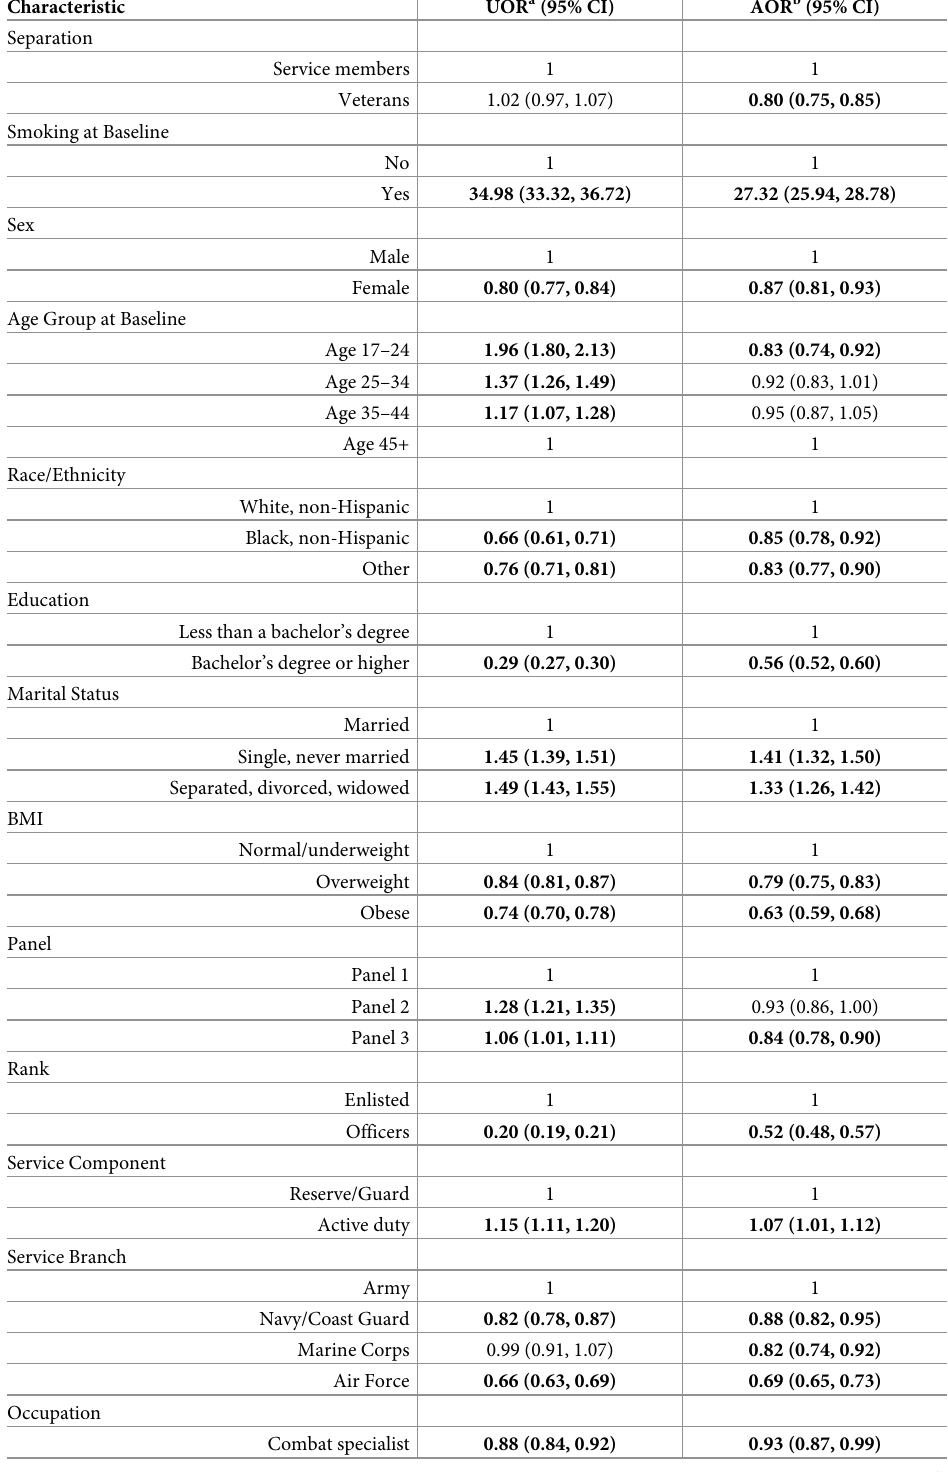
Table 3. Unadjusted and adjusted odds of current smoking status among study participants (N = 67,029), in the Millennium Cohort